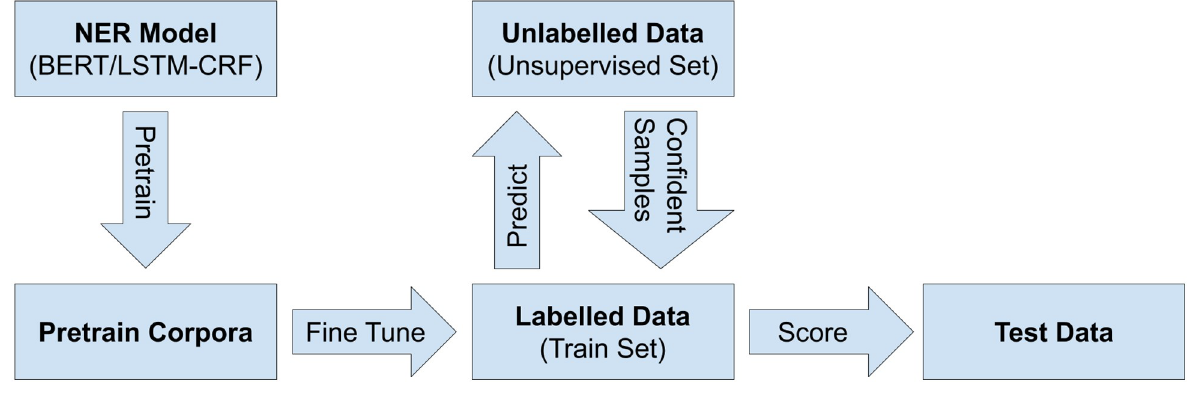
Fig 1. NER workflow used for our